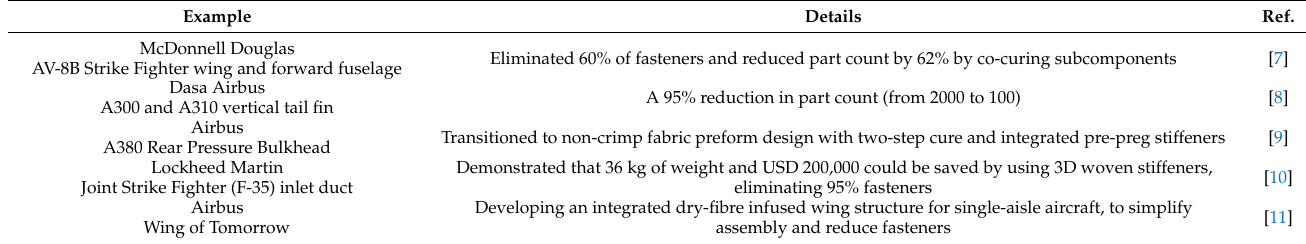
Table 1. Industry examples towards integration of composite assemblies.